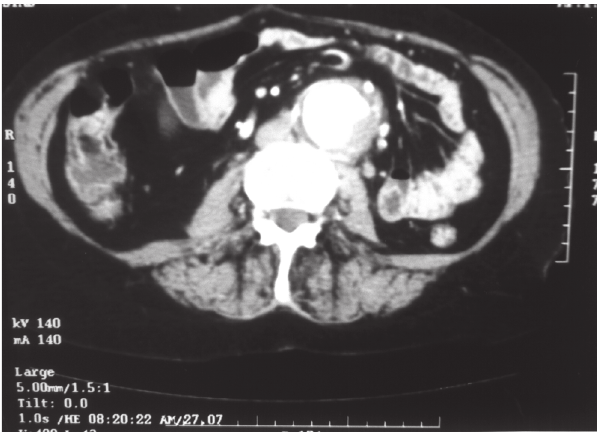
Figure 4 - Conventional tomographic imaging of an abdominal aortic aneurysm.